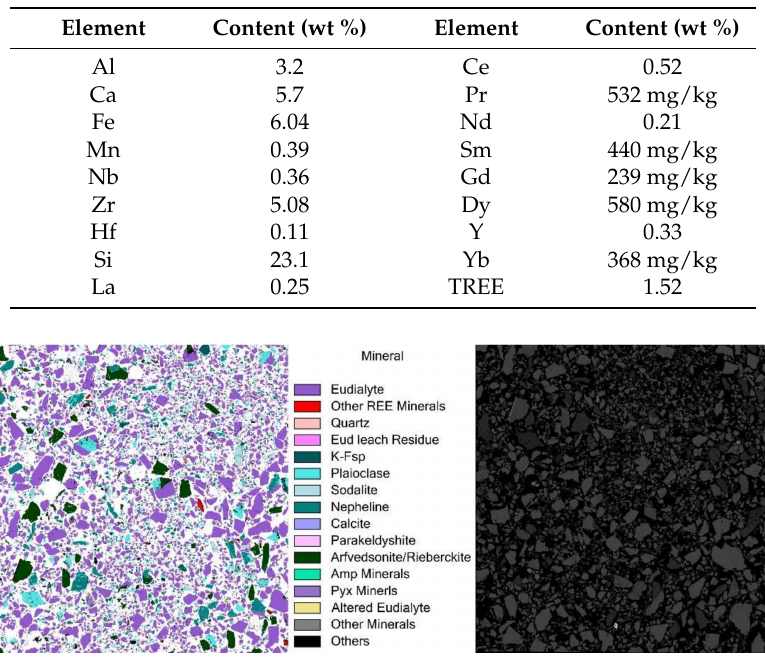
Table 1. Chemical composition of eudialyte concentrate by XRF (X-ray fluorescence).